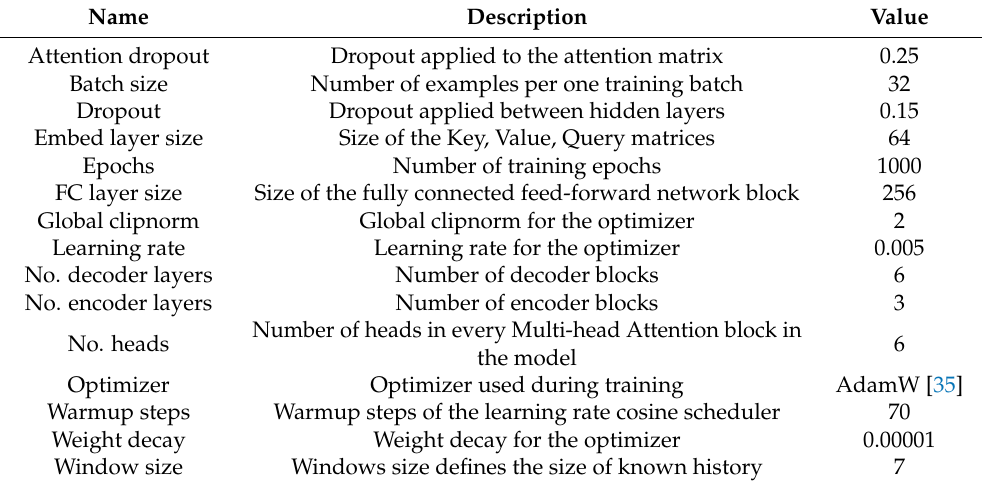
Table 2. The optimized